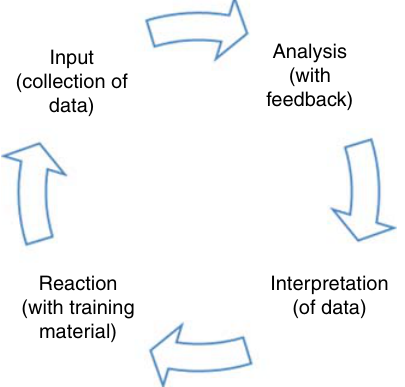
Figure 5. Circular workflow of